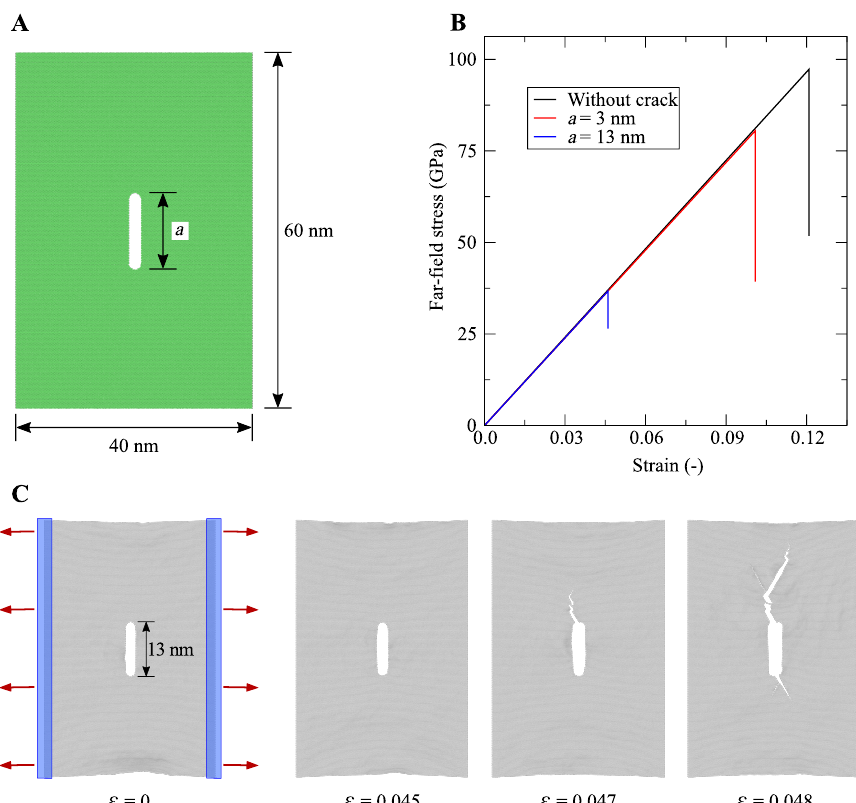
Figure 7. ( A ) An all-atom model of a monolayer graphene sheet under tension with a pre-defined central crack. ( B ) Stress–strain trajectories during brittle fracture. ( C ) The model was pulled on both sides with a constant strain rate, such that pulling directions are perpendicular to the crack depth, which is marked by red arrows. Snapshots illustrating the fracture propagation at subsequent values of the